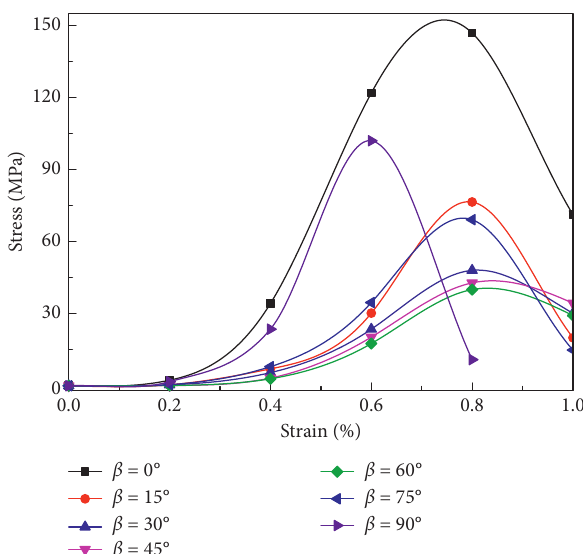
Figure 11: Stress-strain curves of CJB with different joint angles.